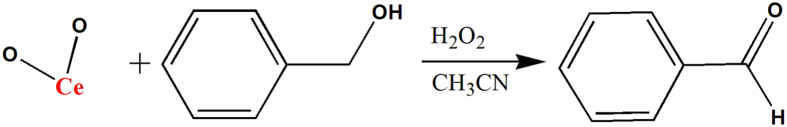
Selective oxidation of benzyl alcohol to benzaldehyde.